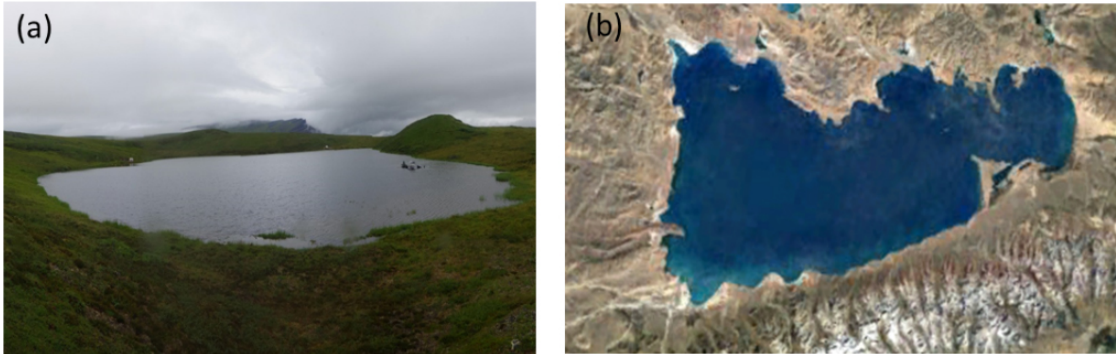
Figure 1. (a) Fog3 Lake and (b) Nam Co ( b from © Google